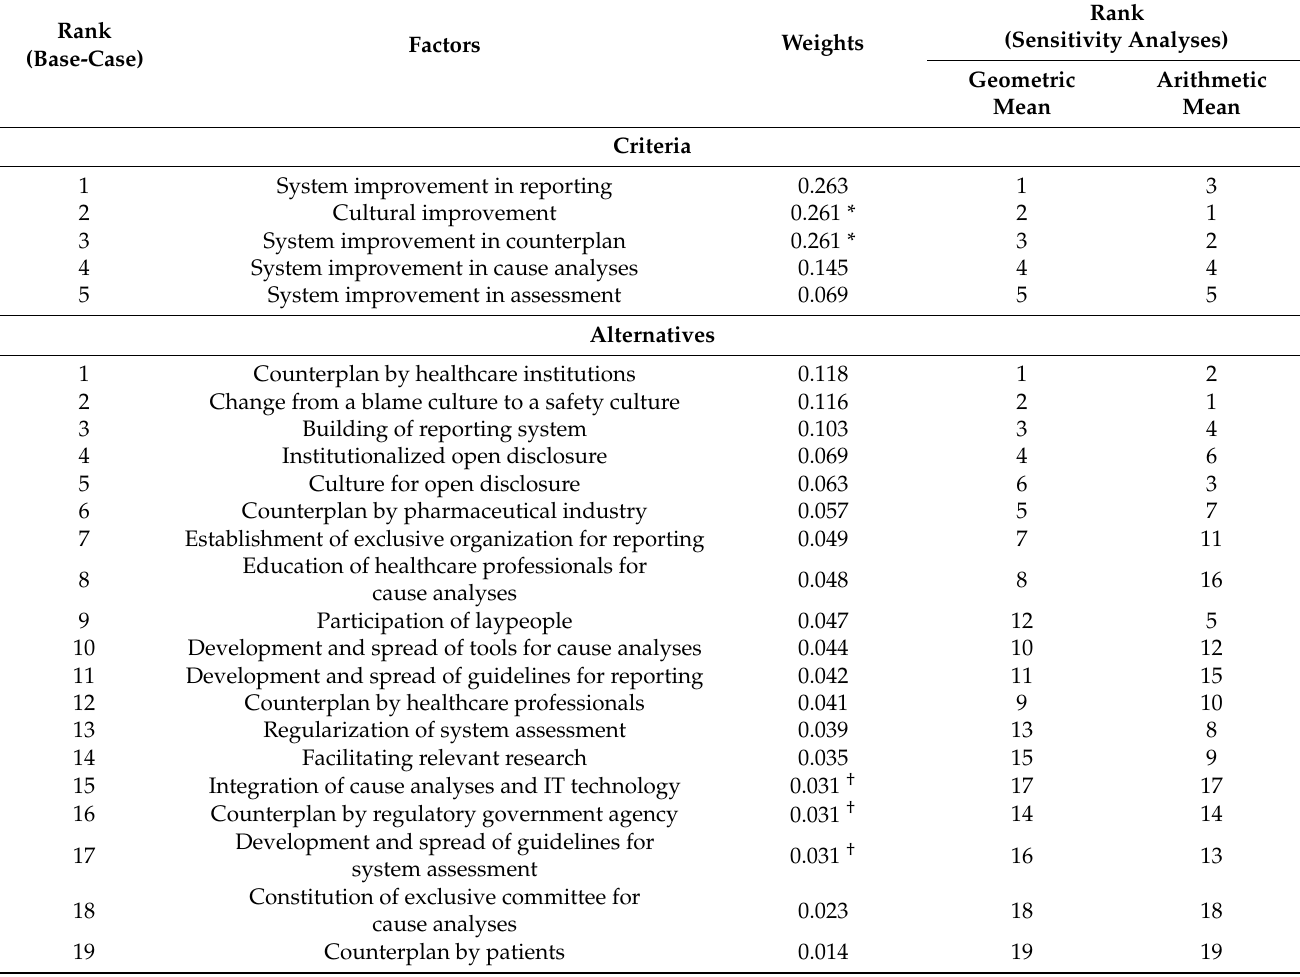
Table 5. Priority of prevention strategies for medication